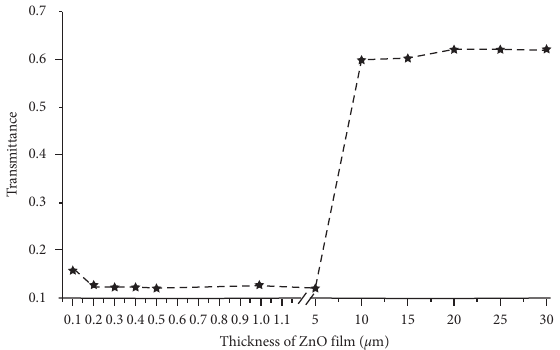
Figure 7: Transmission simulated as a function of ZnO thickness.